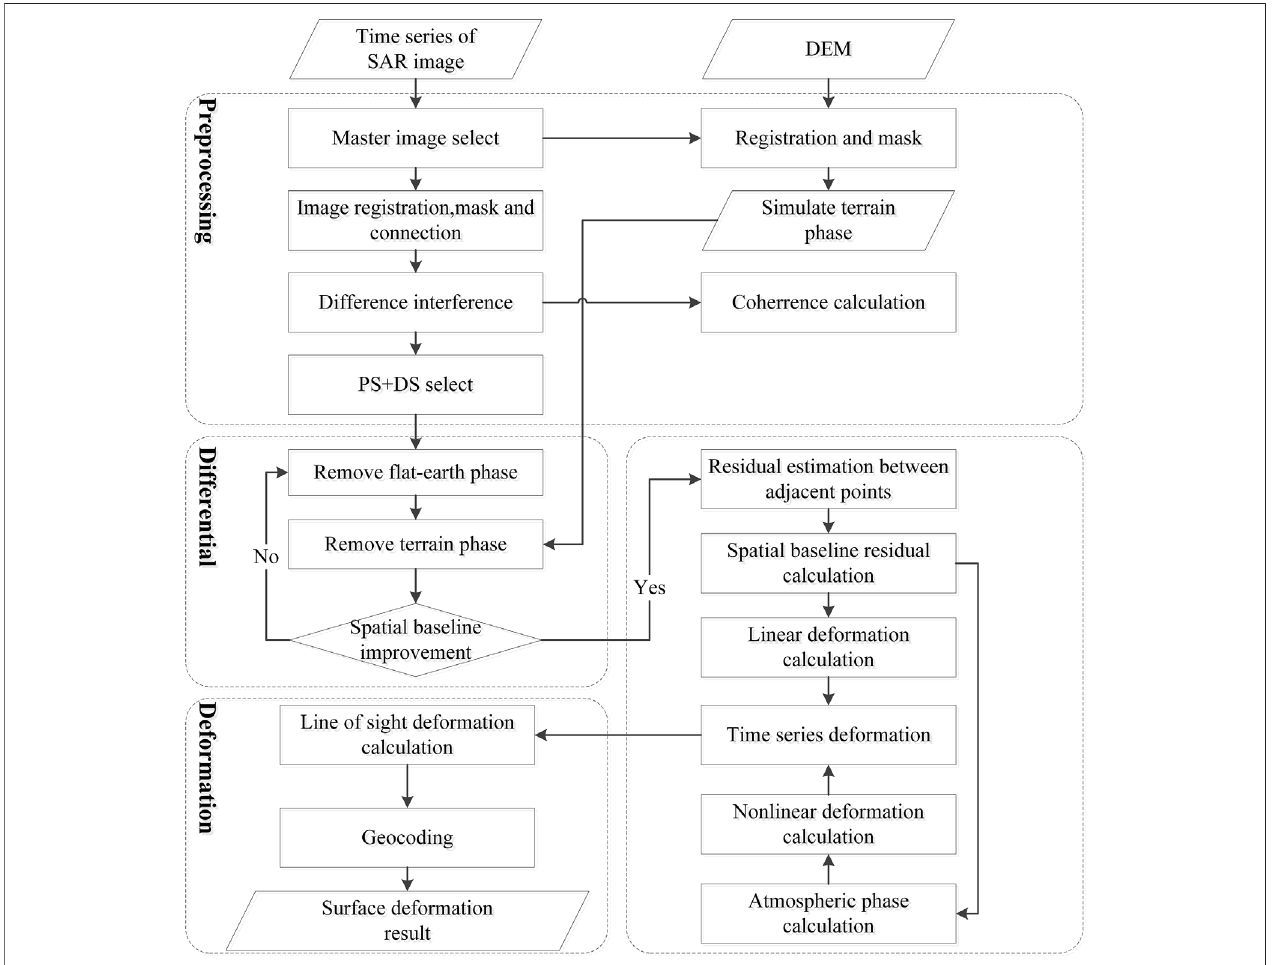
FIGURE 3 | DS-InSAR processing chain used in the